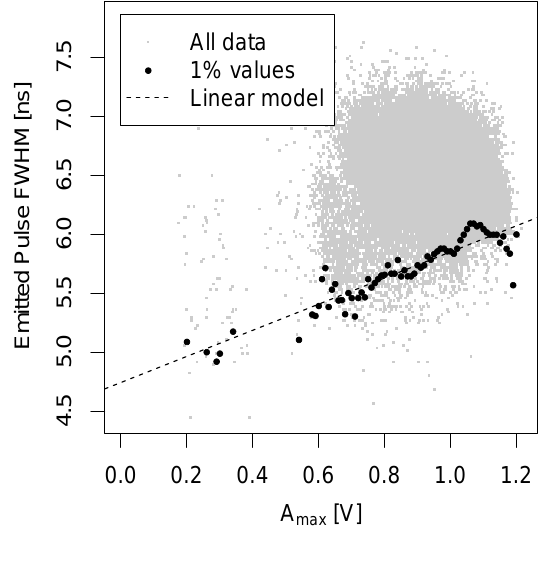
Figure 4. Laser pulse width (FWHM) of G A regression model is formed by use of the 1% values of the G area under Gaussian 1 per 0.01 V intervals (black